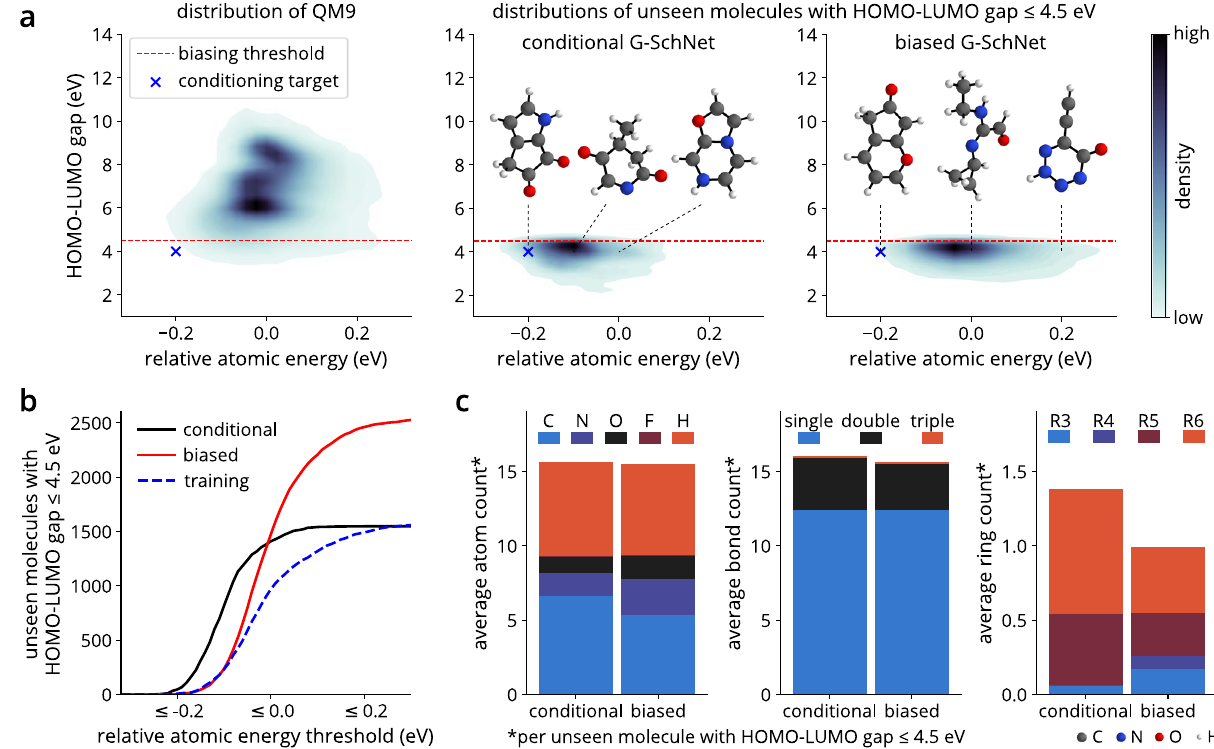
Fig. 5 Discovery of low-energy structures with small HOMO-LUMO gap. We compare cG-SchNet to the previous, biased G-SchNet approach 48 . a The joint distributions of relative atomic energy and HOMO-LUMO gap for QM9 (left) and for unique, unseen molecules with gap ≤ 4.5 eV generated with cG- SchNet (middle) and with biased G-SchNet (right). Biased G-SchNet was fi ne-tuned on all molecules in QM9 below a gap threshold of 4.5 eV (red, dotted line). The conditions used for generation with cG-SchNet are marked with a blue cross. The depicted molecules are generated examples with a gap of 4 eV and different relative atomic energy values (black, dotted lines). More examples as well as the distributions close to the conditioning target for cG-SchNet and the training data can be found in Supplementary Fig. 5. b The absolute number of unique, unseen molecules with gap ≤ 4.5 eV generated by cG-SchNet (black) and biased G-SchNet (red) for increasing relative atomic energy thresholds. For reference, we also show the amount of structures with low gap included in the training set of cG-SchNet (blue dotted line). c The average number of atoms of different types (left), bonds of different orders (middle), and rings of different sizes (right) in unique, unseen molecules with gap ≤ 4.5 eV generated by each